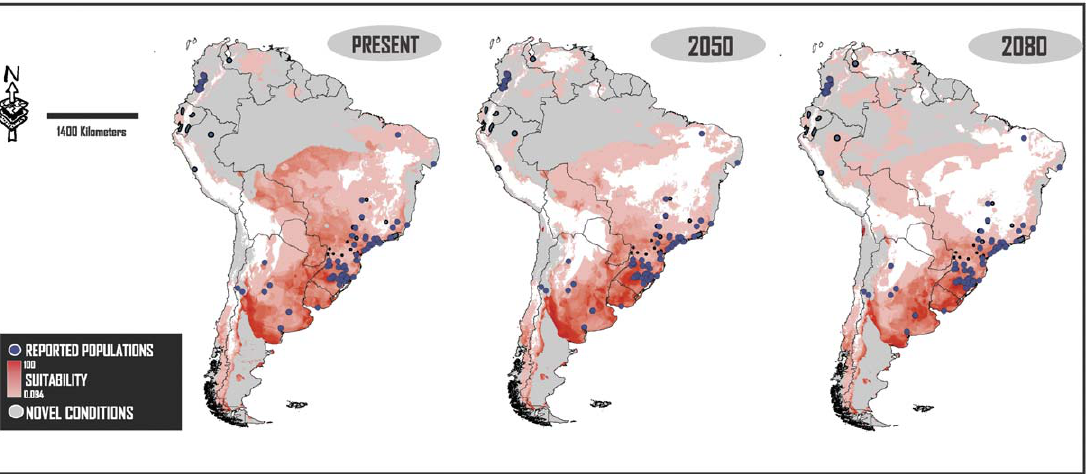
Figure 4. Suitability values and novels conditions of the CCCMA-CGCM31 scenario. Each map shows suitability values (red gradient) and novel conditions (gray) at one of the three analyzed time slices.